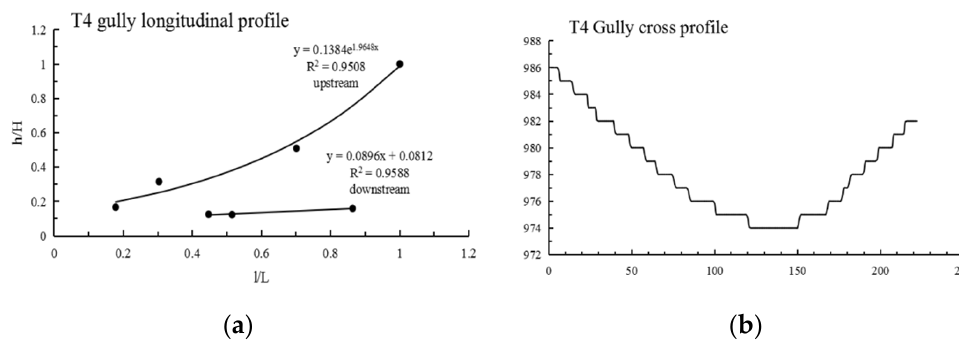
Figure 5. Longitudinal and cross profile fitting diagram of T4.